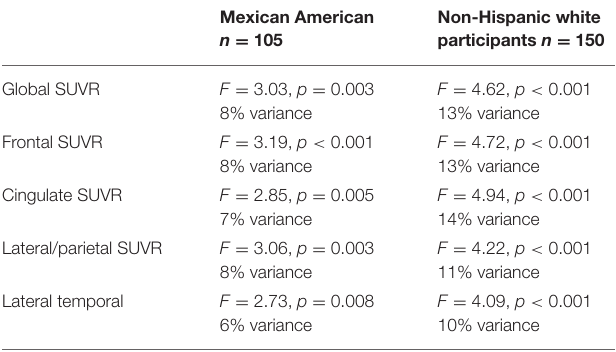
TABLE 2 | APOE ε 4genotype and cerebral amyloid.